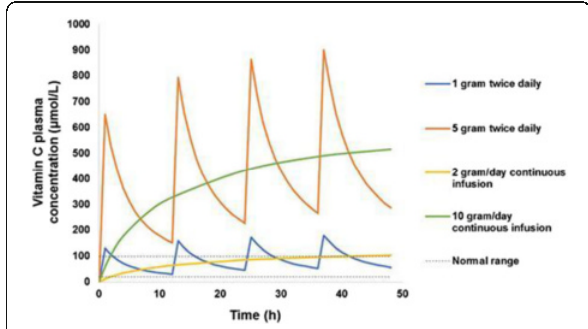
Fig. 23 (abstract A52). Predicted Vitamin C plasma concentrations Table 27 (abstract A52). Excretion of Vitamin C and oxalate B.i.d. bolus regime